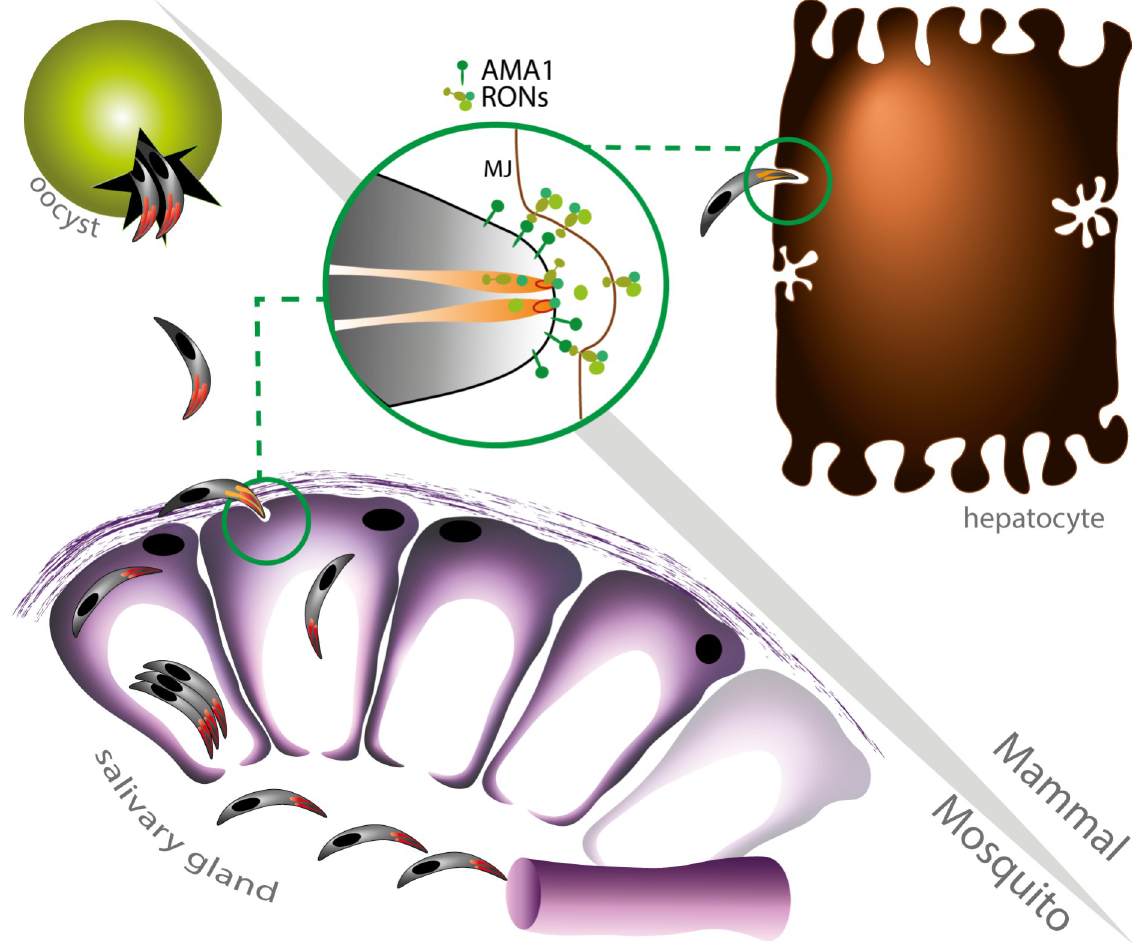
Fig 7. Model of AMA1-RON function in Plasmodium sporozoites. AMA1 and RON proteins drive two distinct sporozoite invasion events in the mosquito and mammalian hosts. After egress from oocysts, sporozoites first rely on AMA1 and RONs to enter the mosquito salivary glands inside a transient vacuole, without causing epithelium damage, to eventually accumulate in the secretory cavities after crossing the acinar cells. Then, following parasite transmission to a mammalian host, AMA1 and RONs are required for efficient productive invasion of hepatocytes inside a parasitophorous vacuole. Both events supposedly involve rhoptry secretion and the formation of a junction, which however is uncoupled from the formation of a canonical parasitophorous vacuole during colonization of the insect salivary glands.